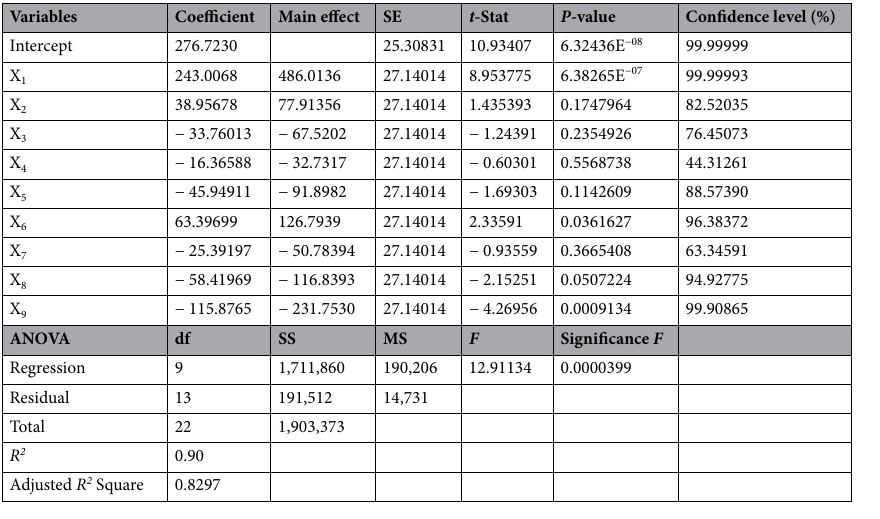
Table 2. Statistical analysis of PBD showing coefficient values, t -values, and ρ -values for each variable affecting ALP